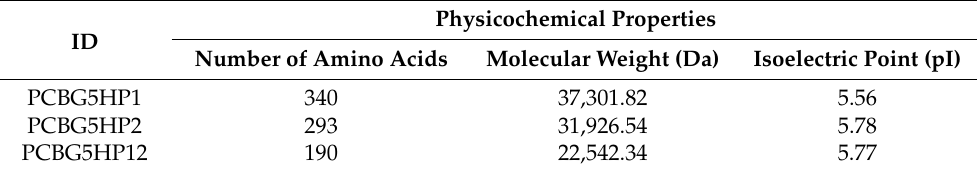
Table 2. The physicochemical properties of P. cryoconitis HPs retrieved by the Protparam